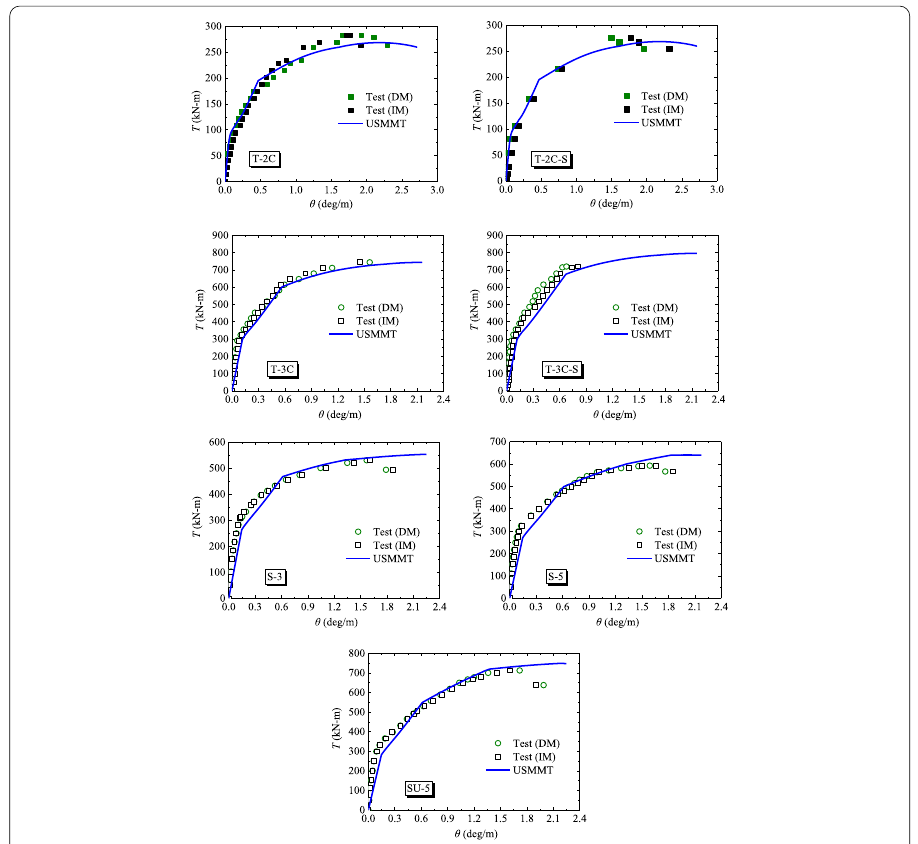
Fig. 5 Comparison of torque-twist curves obtained from tests, and USMMT